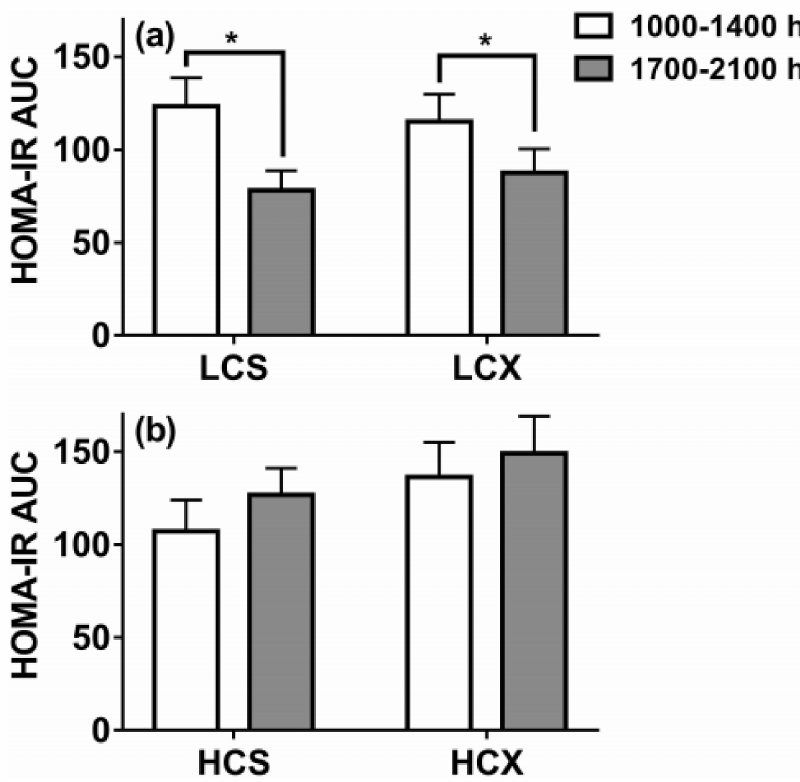
Figure 9. Homeostatic-method measures of insulin resistance based on post-meal insulin and glucose areas under the curve (AUC) after one day of eating low-carbohydrate (30% of energy) or high-carbohydrate (60% of energy) meals while sedentary (LCS and HCS, respectively, ( a ) or after two hours of moderate-intensity pre-meal exercise (LCX and HCX, respectively, ( b ). Data were taken from Reference [75]. Asterisks indicate significant differences ( p <